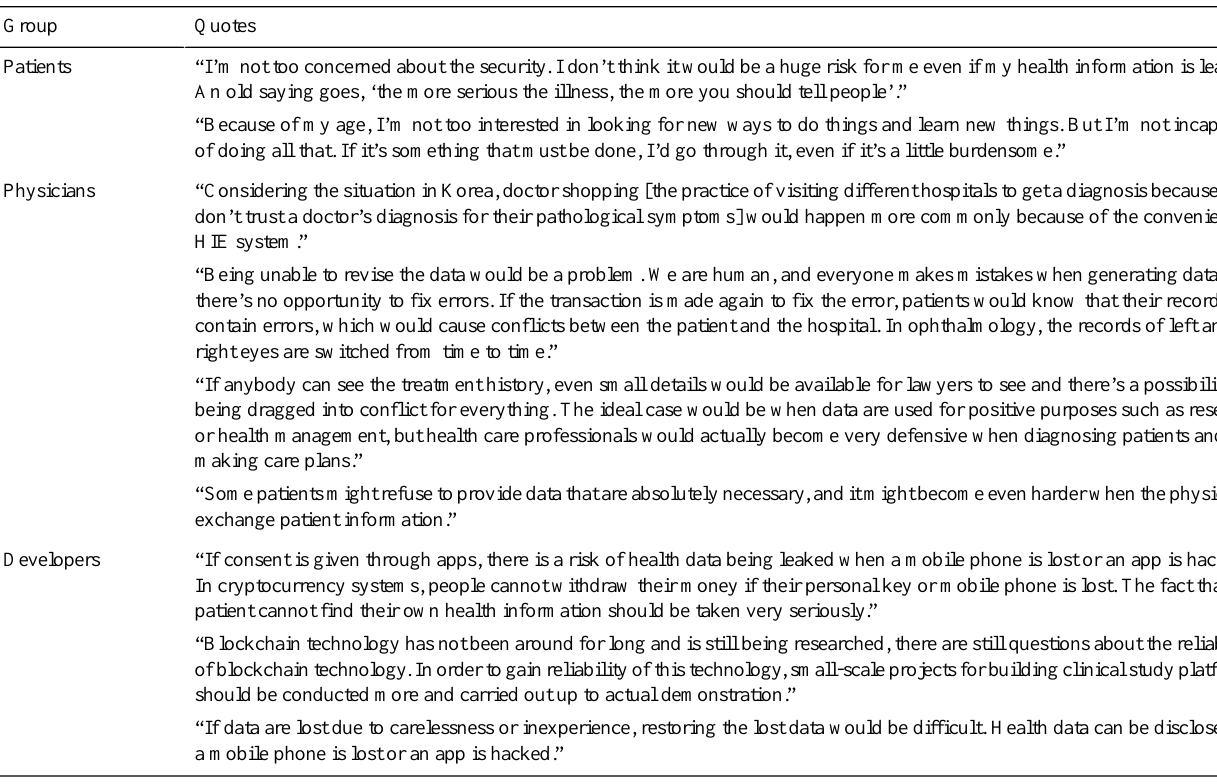
Table 6. Perceived risks of a blockchain-based hospital information exchange (HIE) system.